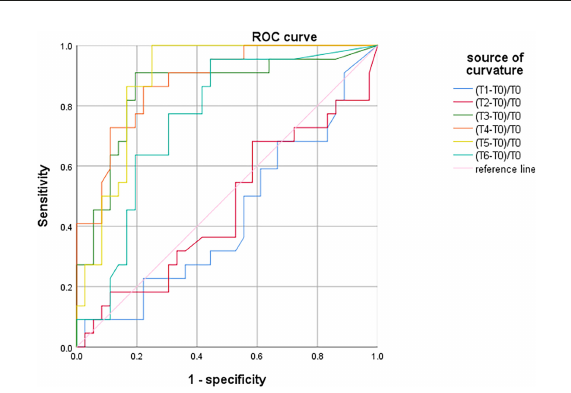
FIGURE6 ROC curve analysis of PND predicted by the maximum percentage decline of SctO 2 in females at each time point.